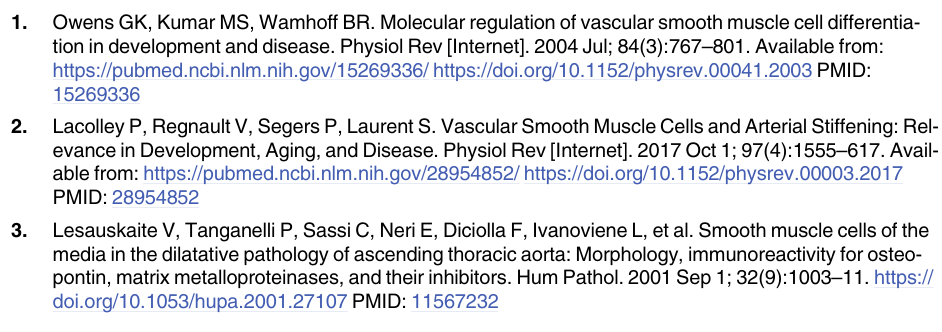
S7 Fig. Lower branch equilibrium solutions only, for different Hill parameters, EC n , which affect the existence and position of the limit point bifurcation. Higher EC 50 damp- ens signal transmission and therefore reduces the strength of the positive feedback, leading to a shift of the limit point bifurcation towards higher PI 3 K . If the signal is sufficiently damped, the limit point bifurcation is not seen. A shift towards higher PI 3 K is also seen for increasing n , although the effect is not as extreme. S1 Text. Table A. Detailed list of species (nodes) and reactions (edges) for the smooth mus- cle cell mTOR network structure, with associated references ( > 100) that motivated the network structure. Inhibition (‘NOT’) is denoted by ‘!’, ‘AND’ statements are denoted by ‘&’, and ‘OR’ statements are constructed by collating all statements with an identical right-hand